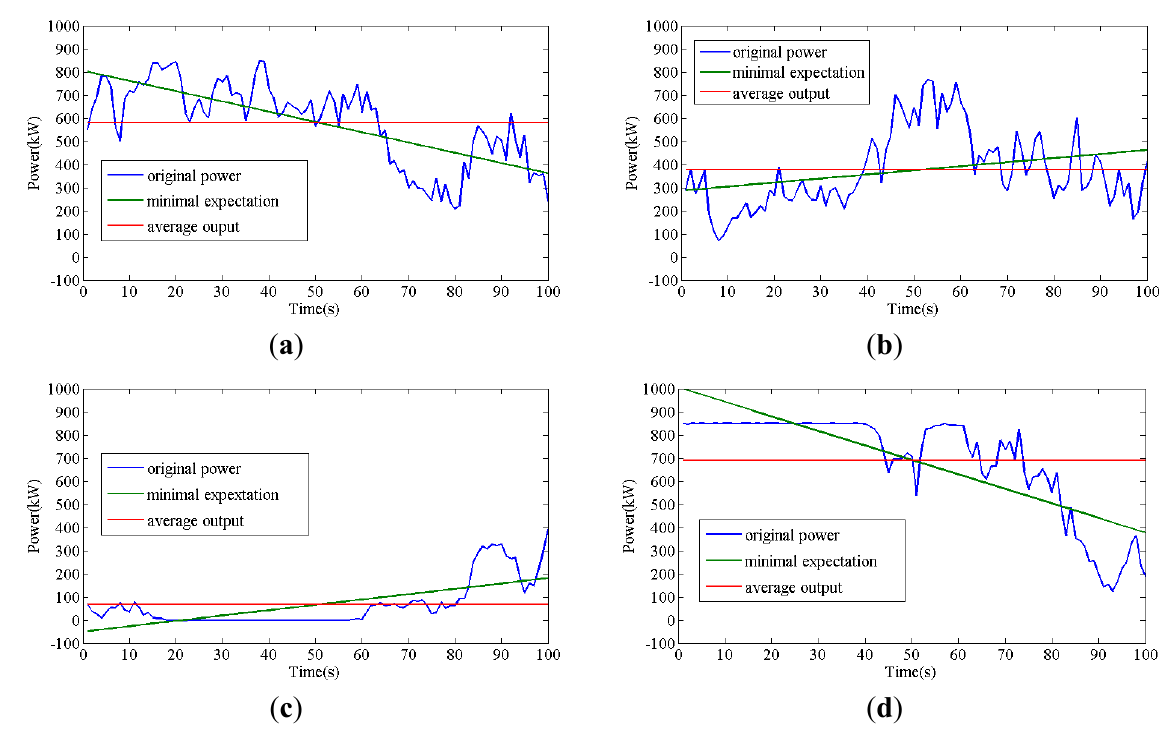
Figure 2. The regulation effect with average output method and the proposed